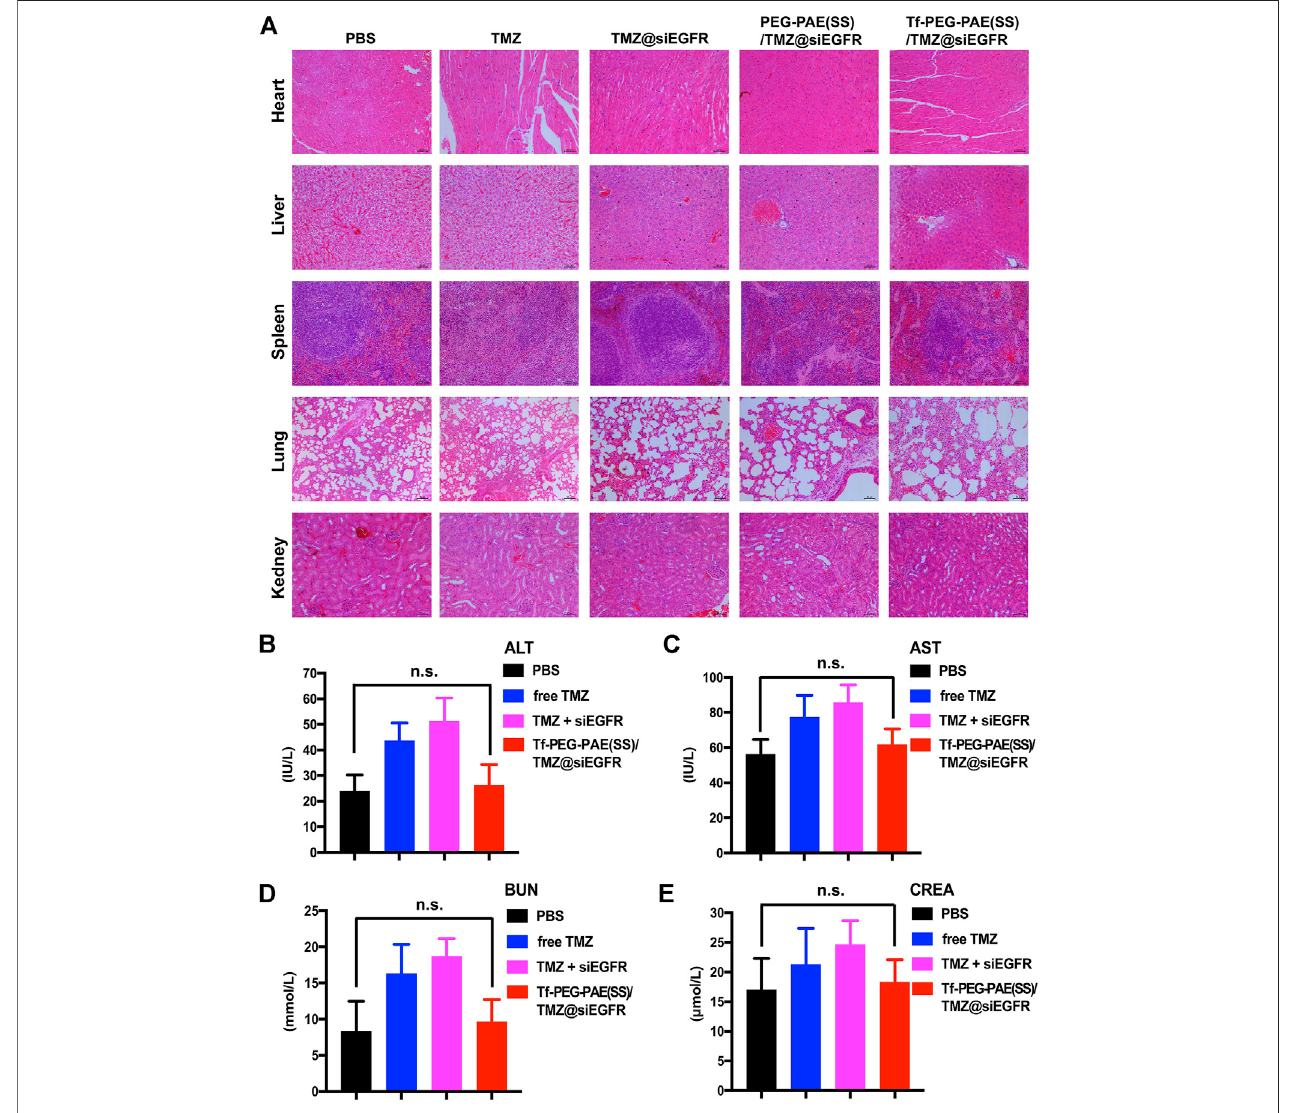
FIGURE 11 | Toxicity study of Tf-PEG-PAE(SS)/TMZ@siEGFR. (A) H&E staining of the heart, liver, spleen, lung, and kidney. (B – E) Biochemical indication levels of ALT, AST, BUN, and CREA of mice after different treatments. (Mean ± SD, n = 3); n.s. indicates no statistical signi fi cance.